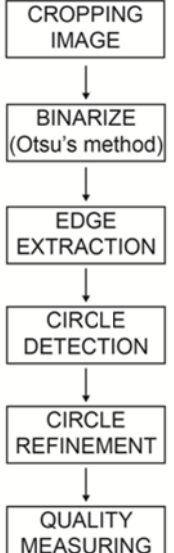
Figure 7. Flow chart from the second method implemented.